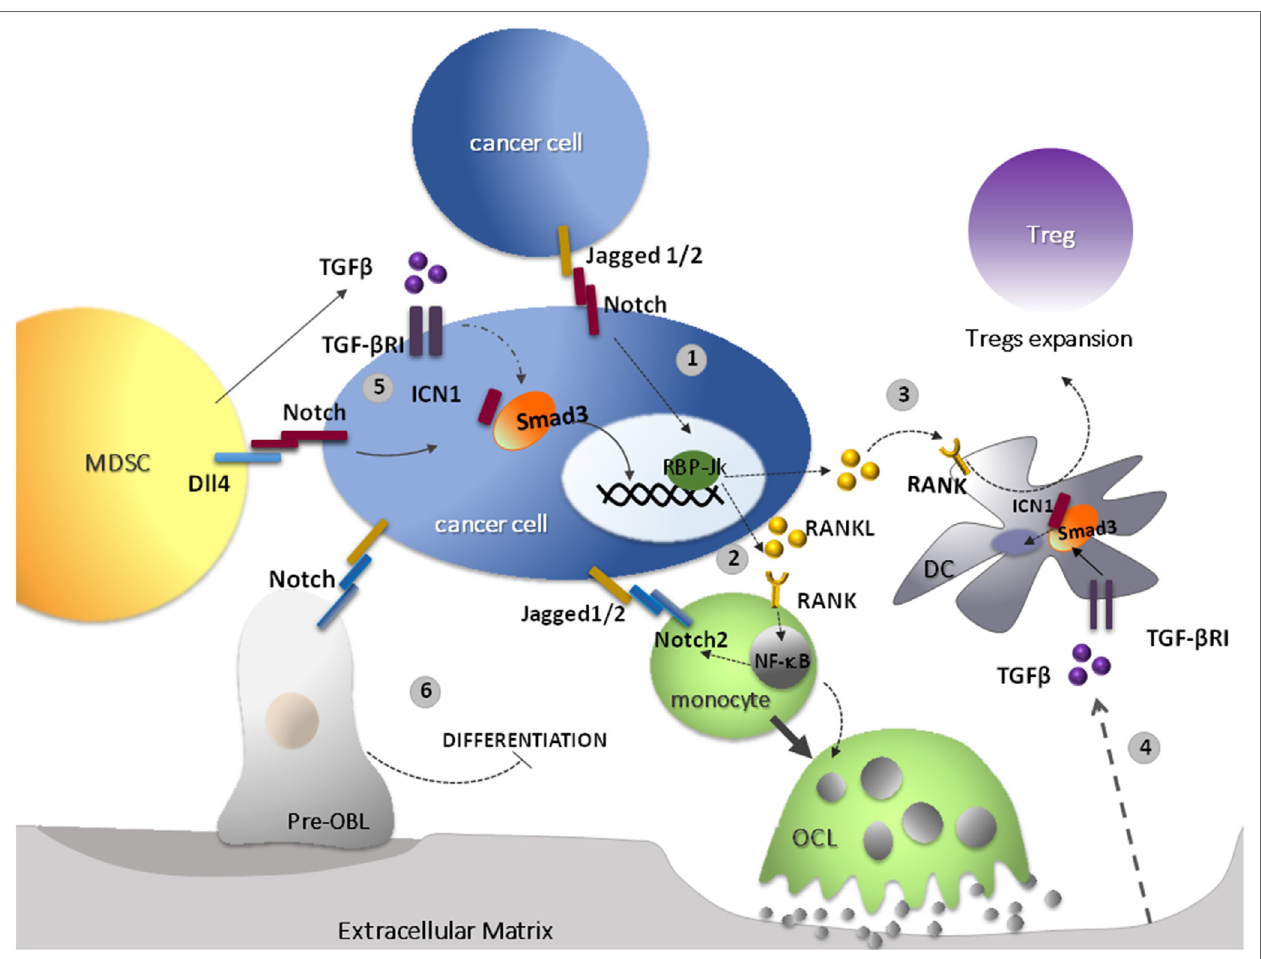
FiGURe 1 | Transforming growth factor- β (TGF- β ) and receptor activator of nuclear factor kappa-B ligand (RANKL) cooperate to suppress the immune response in the bone marrow. 1. In bone-associated cancers, the activation of Notch may be promoted by Jagged1/2 ligands overexpressed by cancer cells; one of the outcomes of Notch overactivation is to increase RANKL expression (52). 2. RANKL represents the main osteoclastogenic factor and promotes osteoclasts (OCLs) differentiation and bone resorption (53). 3. In addition, RANKL plays immunoregulatory functions. RANKL may activate its receptor RANK, which is overexpressed by DCs and, in turn, boosts DCs ability to induce the expansion of the local Treg population promoting tolerance to tumor antigens (54). 4. One of the outcomes of the increased bone resorption is the release of TGF- β from the extracellular matrix (55). 5. TGF- β can be also secreted by tumor and stromal cells and by myeloid-derived suppressor cells (MDSCs) in the tumor microenvironment (TME). Its immunosuppressive effects may be promoted by Notch signaling (see text for details) (41, 51). 6. In specific contexts, such as breast cancer-derived bone metastasis, TGF- β released by cancer cells mediates bone remodeling and stimulates the overexpression of Jagged1 in tumor cells. Jagged1 present on cancer cell surface, in turn, triggers Notch activation in OCLs and osteoblasts (OBLs), promoting the development of tumor-associated bone disease (56).